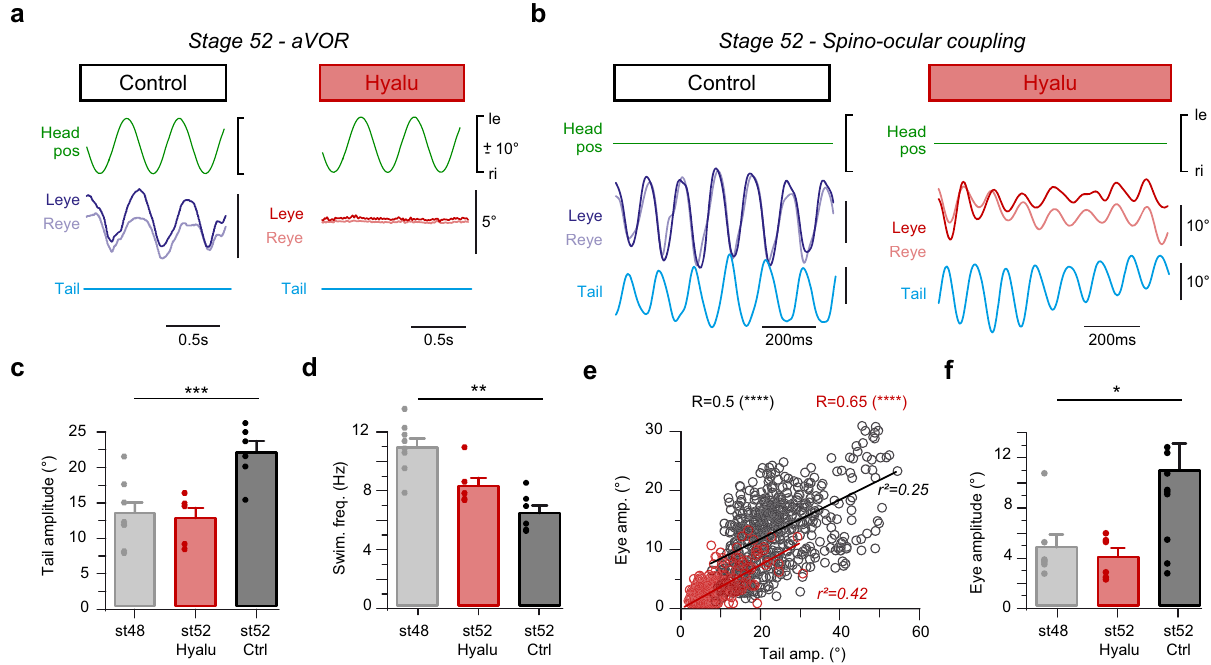
Fig. 3 Semicircular canal de fi ciency prevents maturation of spino-ocular motor coupling. a Movements of the left (Leye) and right eye (Reye) indicative for the angular vestibulo-ocular re fl ex (aVOR) evoked by horizontal sinusoidal head rotation at 1 Hz and ±10° positional (pos) excursion in the absence of swimming ( a ) and for an episode of spino-ocular motor coupling during tail undulations in a head-stationary preparation ( b ); recordings were obtained from a stage 52 control (left column in ( a ), ( b )) and an age-matched semicircular canal-de fi cient tadpole (right column in ( a ), ( b )), respectively; semicircular canal formation was prevented by bilateral intra-otic injections of hyaluronidase (Hyalu) at stage 44. Histogram of swim-related tail undulation amplitude ( c ) and frequency ( d ) during swimming of stage 48 controls (light gray bars, N = 8 ), hyaluronidase-treated stage 52 animals (red bars, N = 6 ) and stage 52 controls (dark gray bars, N = 7 ); statistical signi fi cance was evaluated by the Kruskal-Wallis test, p = 0.002 and p = 0.0003, respectively, for histograms ( c ) and ( d ). Data are presented as mean values ± SEM ( e ) Quanti fi cation of locomotion-induced ocular motor coupling, depicted as scatterplot of eye position amplitudes relative to tail motion amplitudes and linear (lin.) regressions ( r ² ) of stage 52 controls (black circles, n = 560 cycles ) and hyaluronidase-treated age-matched animals (red circles, n = 375 cycles ). Two-tailed p values were calculated to estimate the Pearson coef fi cient correlation (R) signi fi cance and were less than 0.0001. f Histogram of average eye position amplitudes during spino-ocular motor coupling of stage 48 controls (light gray bars, N = 8), hyaluronidase-treated stage 52 animals (red bars, N = 6) and stage 52 controls (dark gray bars, N = 7); statistical signi fi cance of the Kruskal-Wallis test, p = 0.0209. Data are presented as mean values ± SEM. Statistical signi fi cance is indicated as *** p < 0.001, ** p < 0.01, * p < 0.05 in ( c – f ); le, ri, leftward, rightward movement. Source data are provided as a Source Data fi